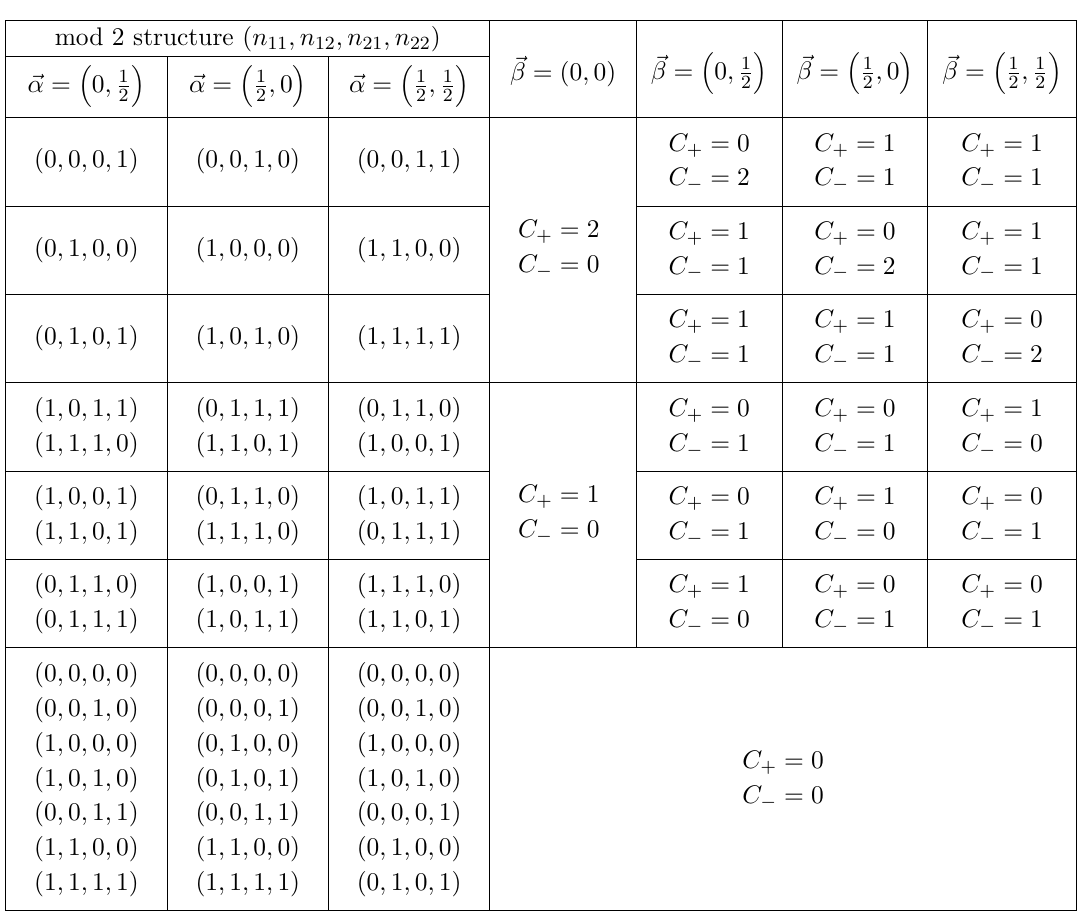
(cid:0) (cid:1) (cid:0) 1 (cid:1) (cid:0) 1 (cid:1) 0 , 1 , , 0 , , 1 2 2 2 2